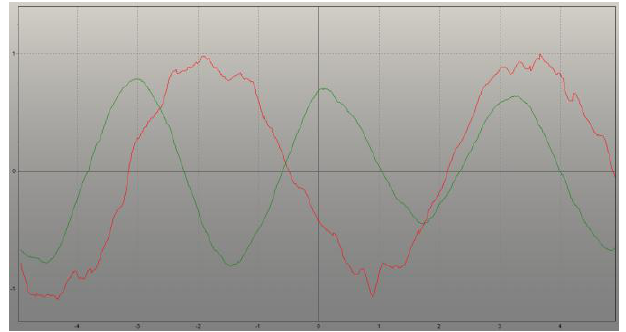
Figure 9. Waveforms of excitation (light) and stator (dark) DFIG